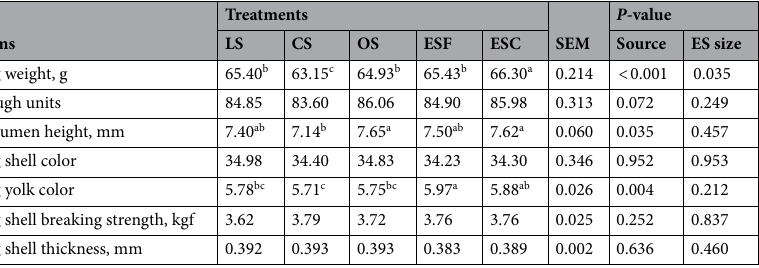
Table 2. Egg quality traits of laying hens according to the treatments between 73 and 80 wk of age. Results are the means of randomly sampled 280 eggs per treatment (40 eggs per treatment at each week; 4 eggs per replicate) during 73 to 80 week of age. LS limestone (< 2 and 2–4 mm mixed in 3:7); CS cockle shell (1–4 mm); OS oyster shell (3–16 mm); ESF eggshell fine particles (< 1 mm), ESC eggshell coarse particles (3–5 mm). SEM standard error of means, ES eggshell. a-c Means with the different superscript in the same row differ significantly ( P < 0.05).